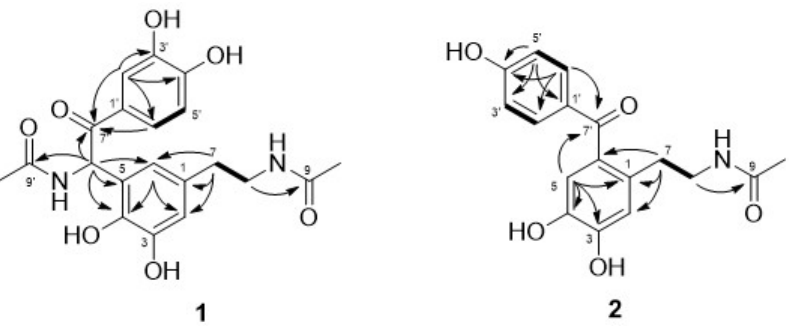
Figure 2. Key HMBC (arrow) and COSY (bold) correlations ( 1 and 2 ). Compound 1 is a racemic mixture, which was suggested by the lack of an optical rotation value. Therefore, chiral separation was performed on a Chiralpak IH column to yield optically pure enantiomers 1a (+21.2 ( c 0.01, MeOH)) and 1b ( − 21.0 ( c 0.01, MeOH)) (Figure 3). The absolute configurations of 1a and 1b were determined by comparing the calculated and experimental ECD spectra. The calculated ECD spectra of the 8 ʹ R and 8 ʹ S stereoisomers were in good agreement with the experimental spectra of 1a and 1b , respectively (Figure 4). Therefore, the structures of new compounds 1a and 1b were assigned as (+)-tenoderin A and ( − )-tenoderin A, respectively.